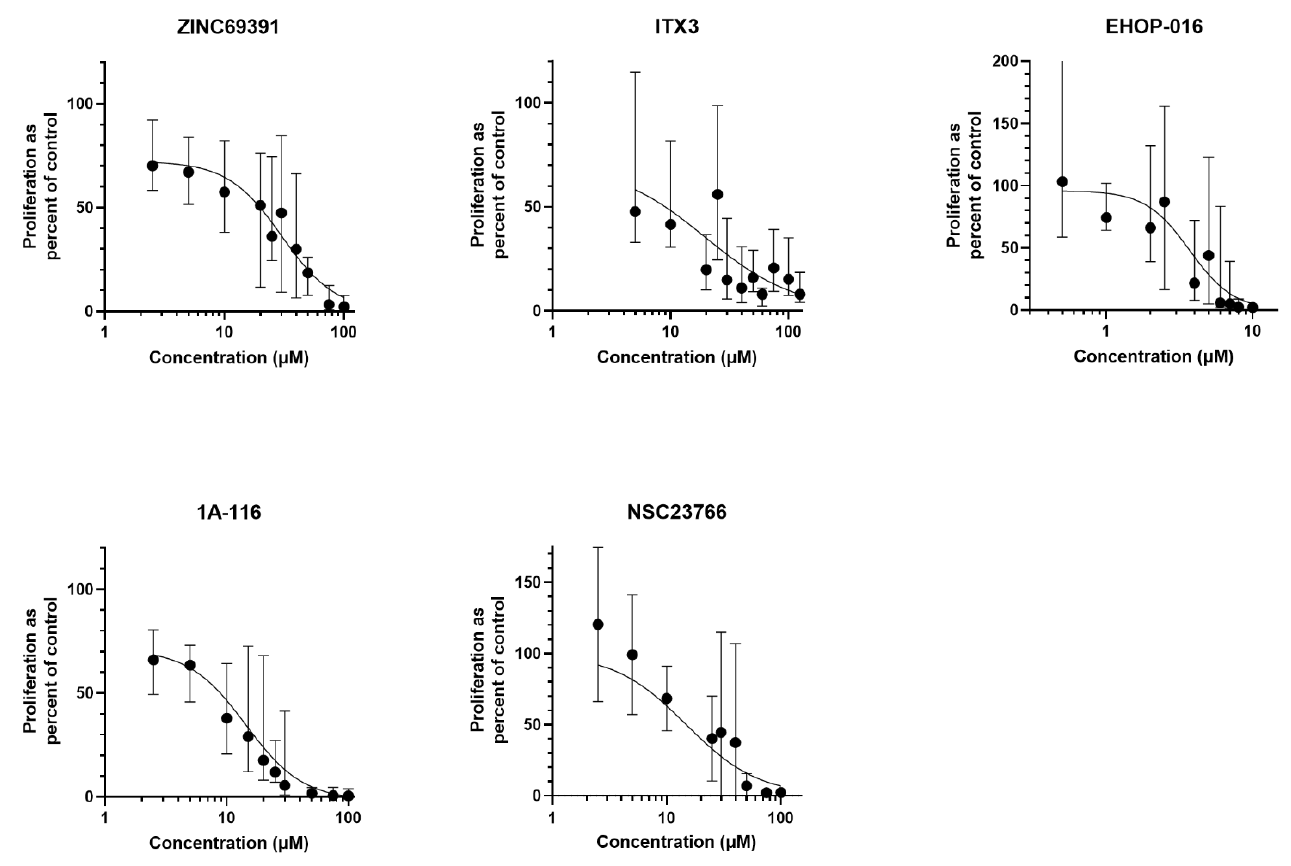
Figure 1. Pilot dose-response curves. Dose-response curves (non-linear fit) for each of the five inhibitors were made with a pilot 3 H-Thymidine proliferation assay after seven days of culture. Proliferation as a ratio to the untreated control on the y-axis, with the untreated control set to 100%. Few patient samples were cultured with each concentration; each dot is the median with a 95% confidence interval (CI) as an error.